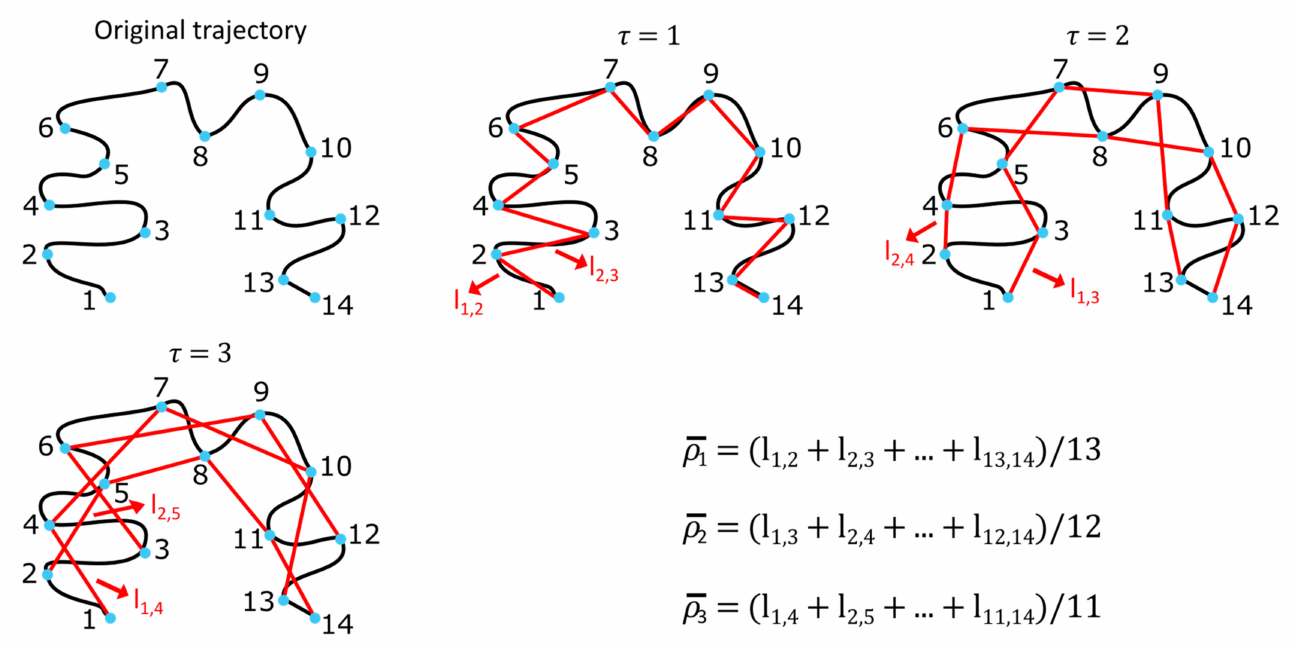
Figure 1. Schematic representation of the mean squared displacement (MSD) calculation for a trajectory comprising 14 points. The MSD is calculated up to τ = 3, according to Saxton’s rule